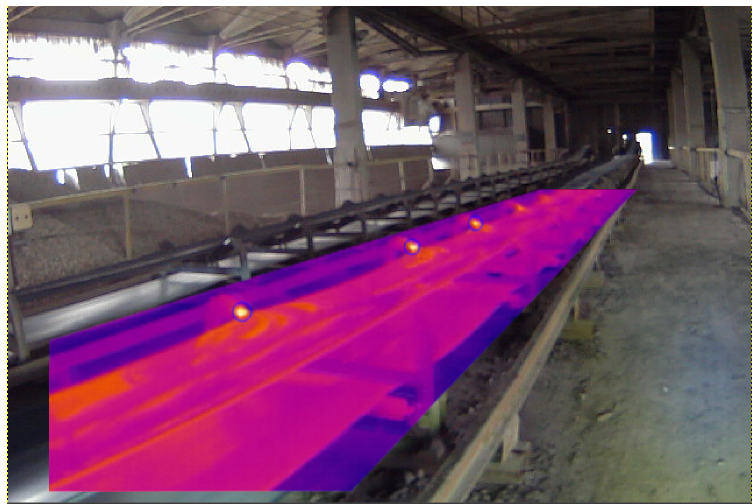
Figure 16. Algorithm result visualisation on starting